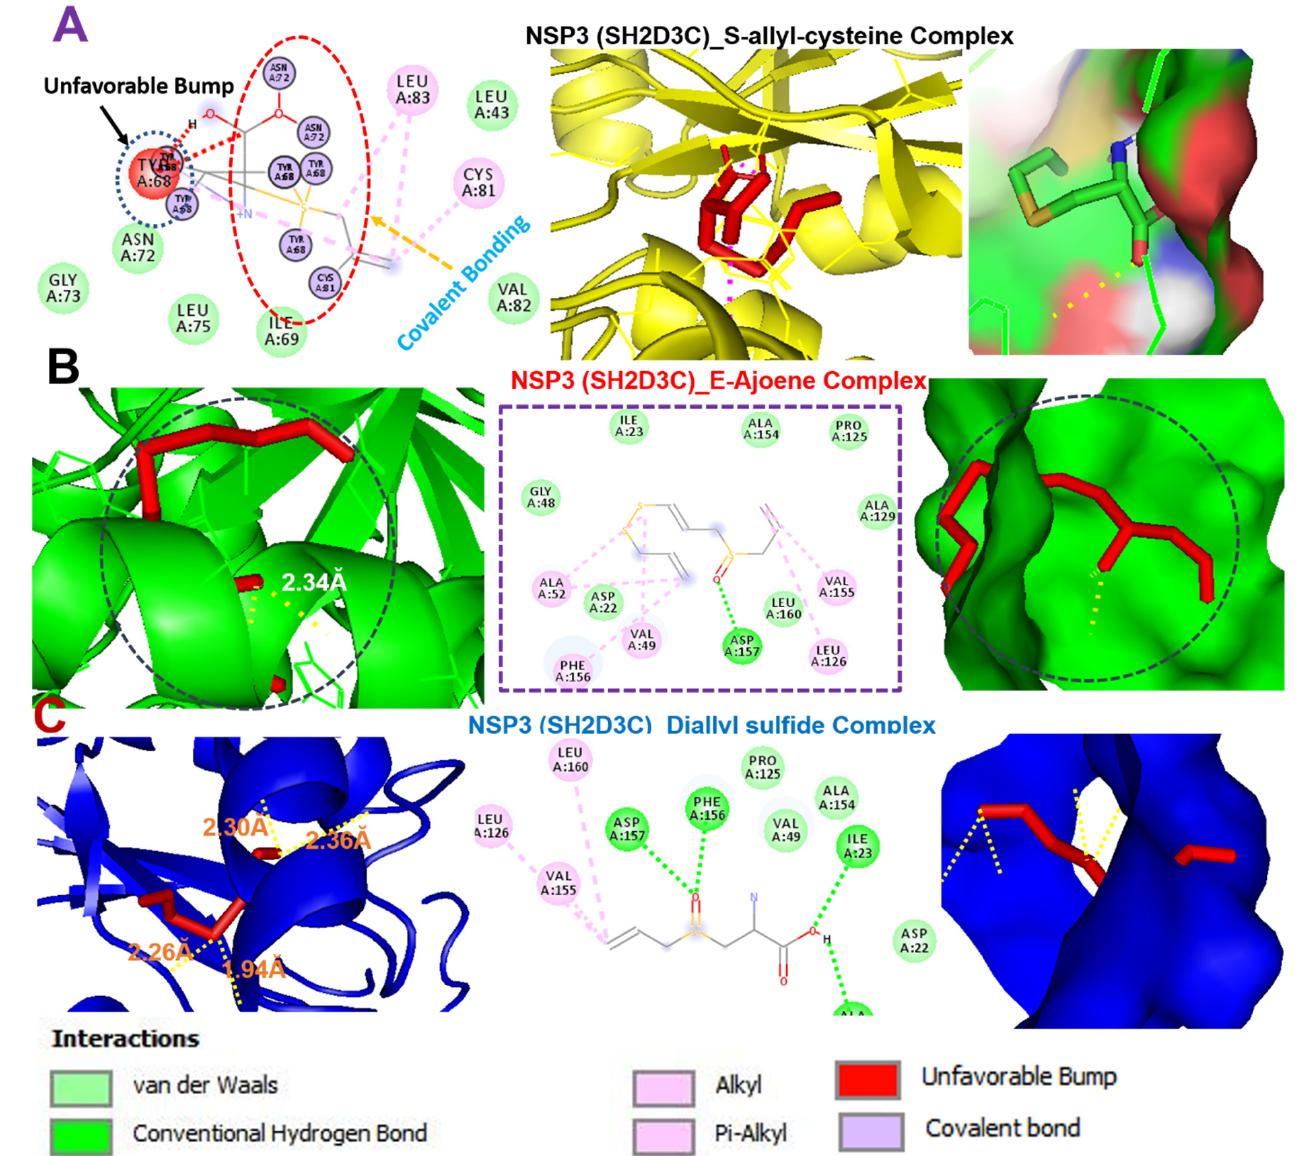
Figure 8. Molecular docking profile on NSP3 (PDB: 6W6Y) with the organosulfur small molecule from Allium sativum. Two-dimensional (2D) structure and binding surface flip of the ligand − receptor interactions between NSP3 (SH2D3C) and